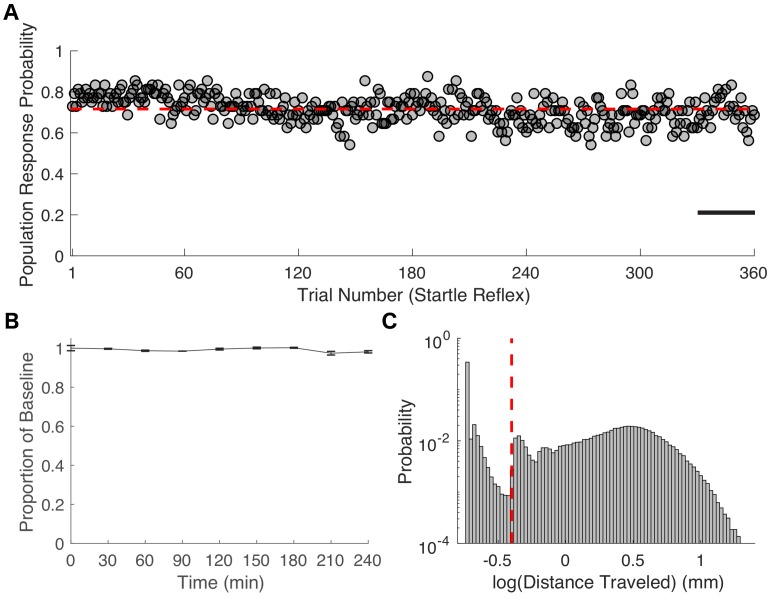
Characterization of zebrafish startle response.(A) The population response probability averaged across 48 zebrafish exposed to E3 larval medium alone is 0.72 ± 0.07 (mean ± SD, red line in A). SR was assessed every 30 s for 3 hrs after a 1-hr equilibration period. (B) Propofol concentrations remained constant for the duration of a 4-hr exposure. Propofol concentrations were measured in triplicate at 30-min intervals (ThermoFischer Scientific NanoDrop Spectrophotometer). (C) Distribution of velocities elicited by a tap stimulus is bimodal. For the purposes of classifying startle reflex (SR) as responsive or unresponsive, the distance travelled in the first second after the tap stimulus was thresholded at 0.4mm (dashed red line). Scale bar represents 15 min.